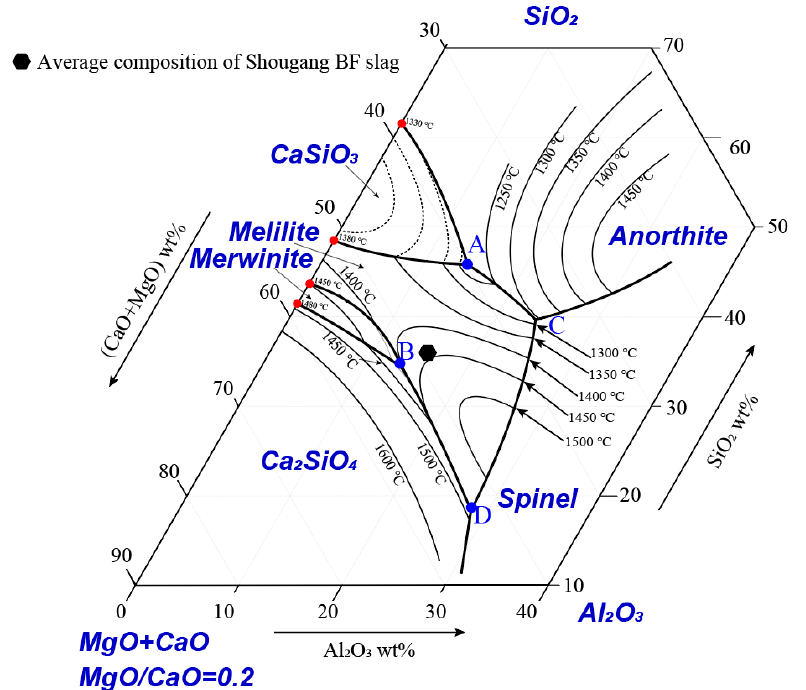
Figure 17. Experimentally determined pseudo-ternary phase diagram (CaO + MgO)-Al 2 O 3 -SiO 2 at a constant MgO/CaO ratio of 0.2 [23].